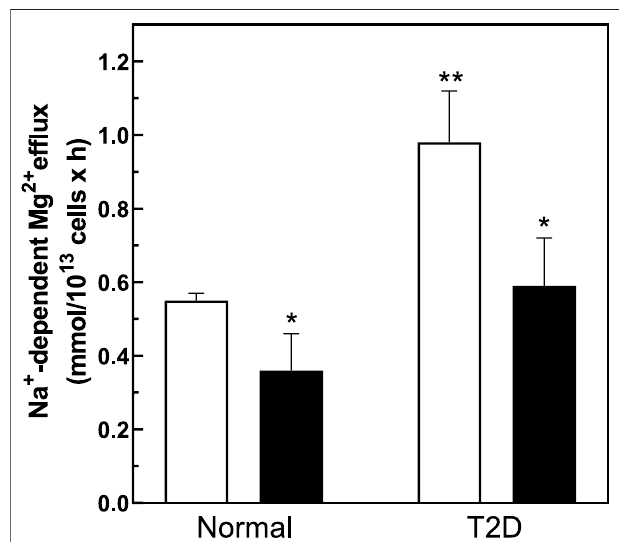
FIGURE 6 | Regulation of the Na + /Mg 2+ exchanger activity by PNGase treatment. Cells from normal and diabetic subjects were pre-incubated in the absence(whitebar)orpresence(blackbars)of0.1 U/mLPNGaseFfor1.5 hand assayed for Na + /Mg 2+ exchanger activity as described in Methods . Values are expressed as means ± SEM of three and fi ve experiments in triplicate determinations in normal and diabetic subjects, respectively. Non-parametric paired t test of control vs. de-glycation in both normal (* p < 0.03) and diabetic subjects(* p < 0.001).Unpairedttestnonparametricofcontrolinnormalvs.control in diabetic subjects (** p < 0.0001).